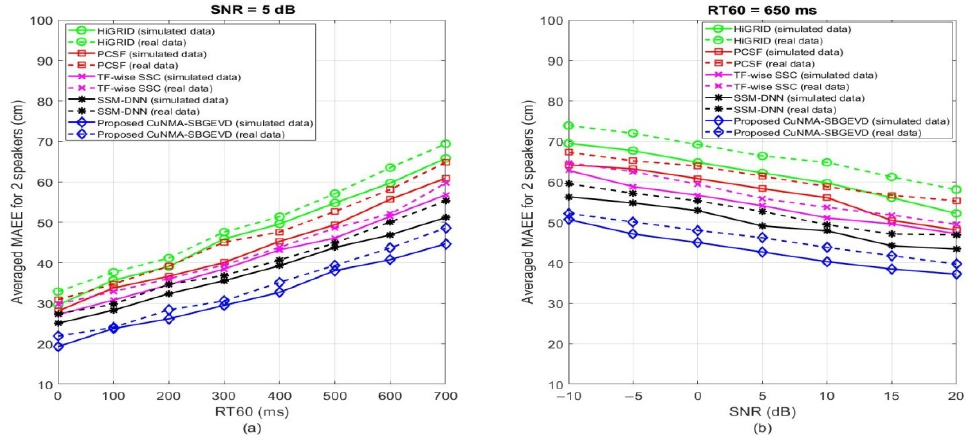
Figure 13. The averaged mean absolute estimation error (MAEE) curves for the proposed cuboids nested microphone array (CuNMA)-subband generalized eigenvalue decomposition(SBGEVD) in comparison with hierarchical grid (HiGRID), perpendicular cross-spectra fusion (PCSF), time-frequency wise spatial spectrum clustering (TF-wise SSC), and spectral source model-deep neural network (SSM-DNN) on real and simulated data for 2 simultaneous speakers, ( a ) for SNR = 5 dB and 0 < RT 60 < 700 ms, and ( b ) for RT 60 = 650 ms and − 10 < SNR < 20 dB.